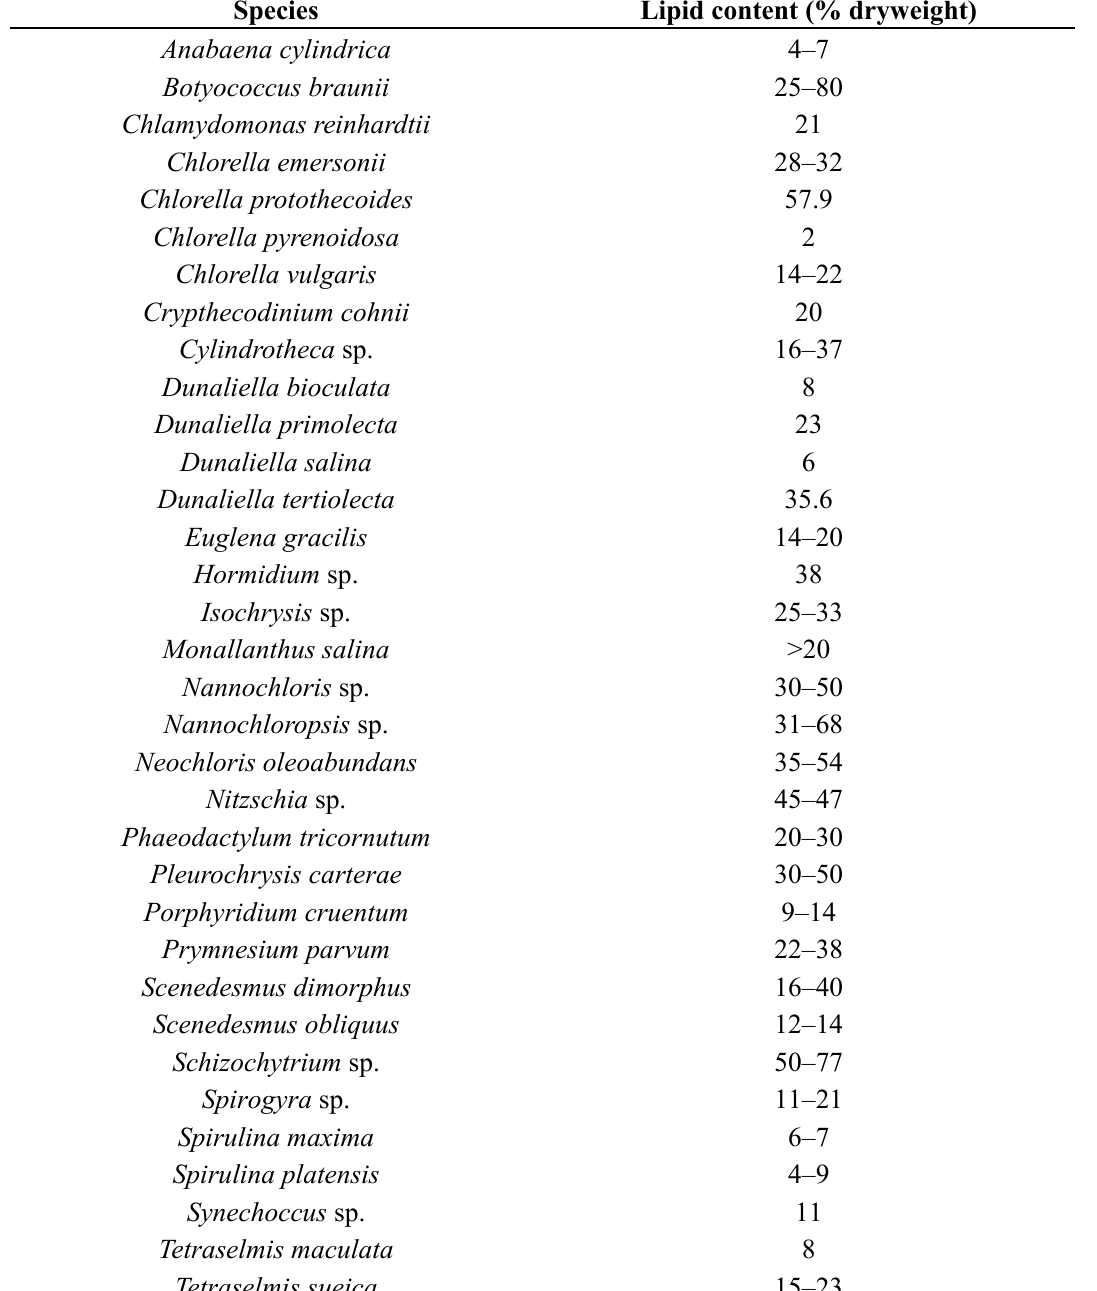
Table 2. Lipid content in the dry biomass of various species of